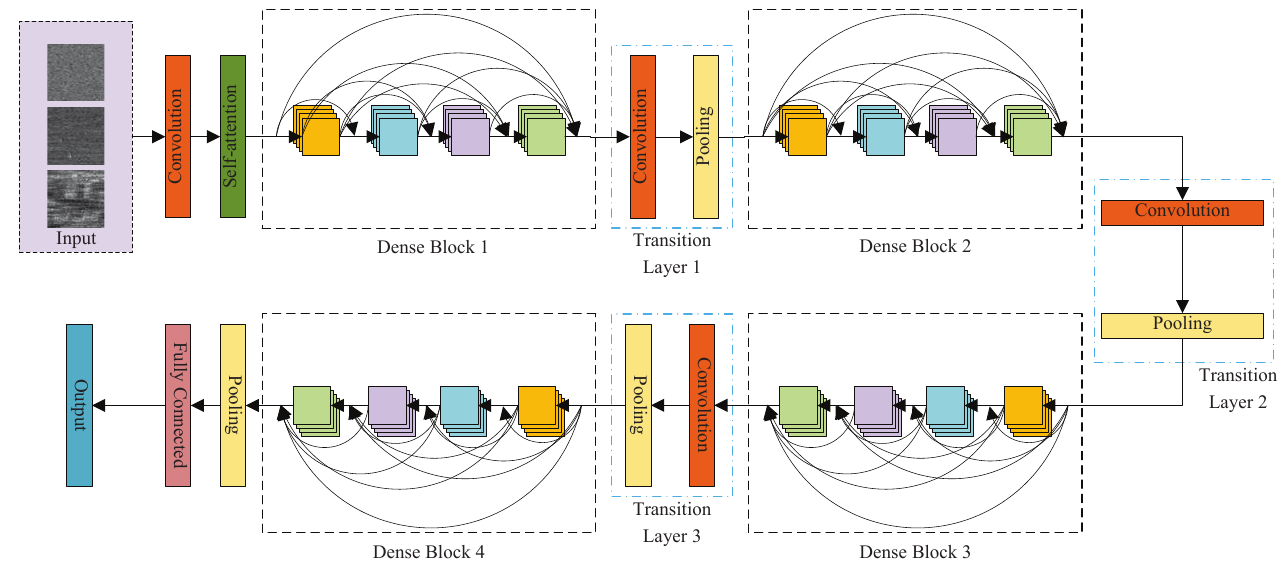
Figure 5. The proposed SADenseNet has four dense blocks. There is a transition layer between adjacent dense blocks, which reduces the dimensionality of the features and makes them uniform in size, which greatly improves computational